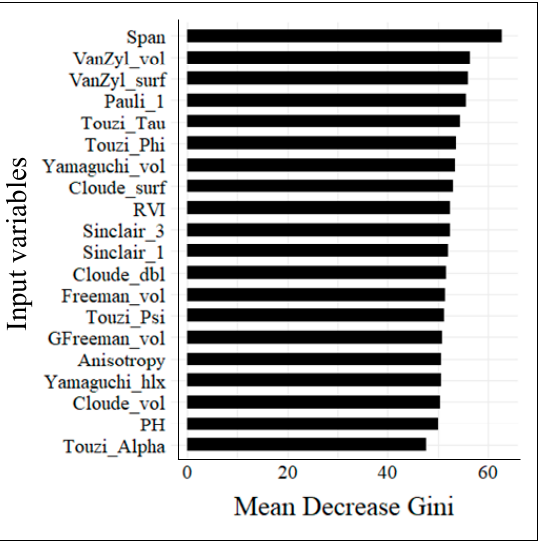
Figure 6. Importance evaluation of the input variables of the random forest algorithm used for predicting PWN infestation from Radarsat-2 image.